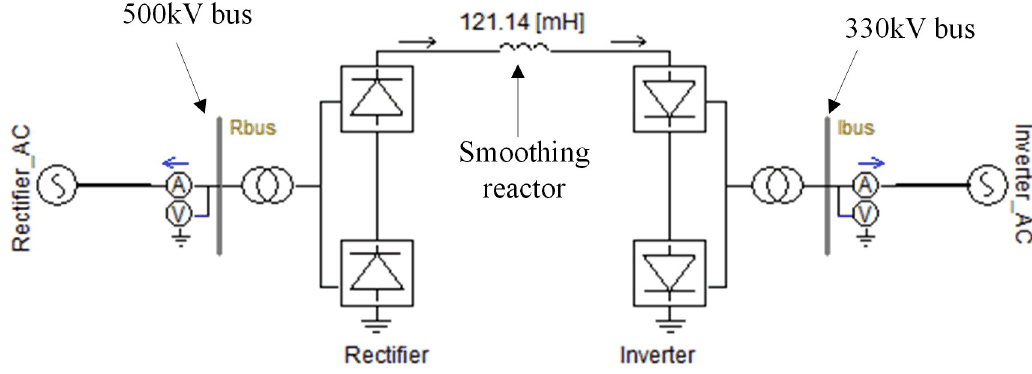
Fig 15. Simulation model of the back-to-back HVDC system.